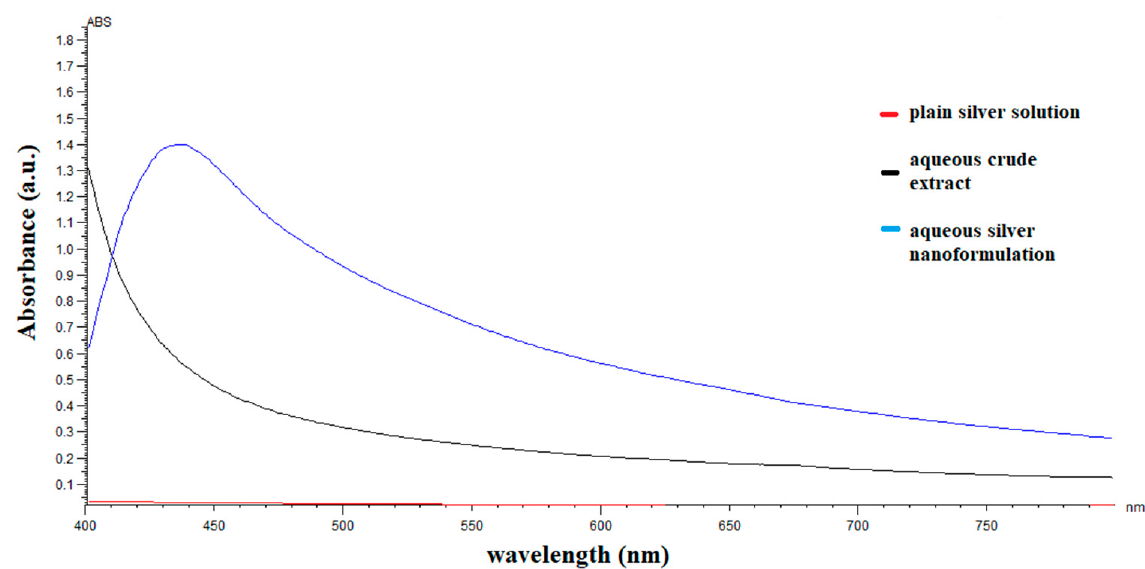
Figure 1. UV–visible spectra of aqueous extract of C. papaya leaf-silver nanoparticles and absorbance peak noted at 450 nm.